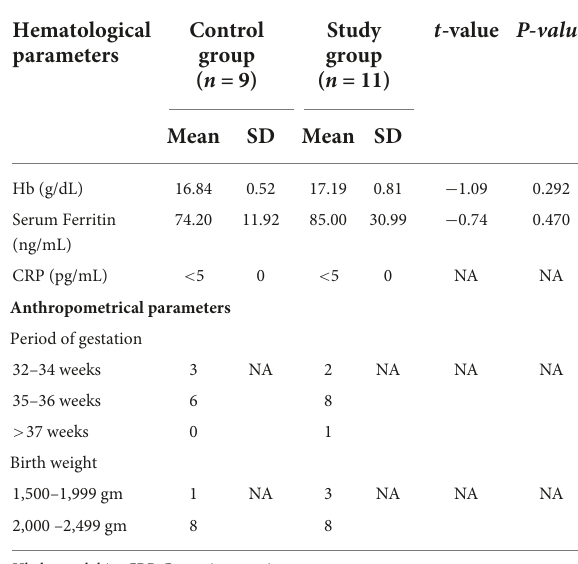
TABLE 6 Baseline hematological parameters of infants at recruitment who developed anemia during follow up and received iron